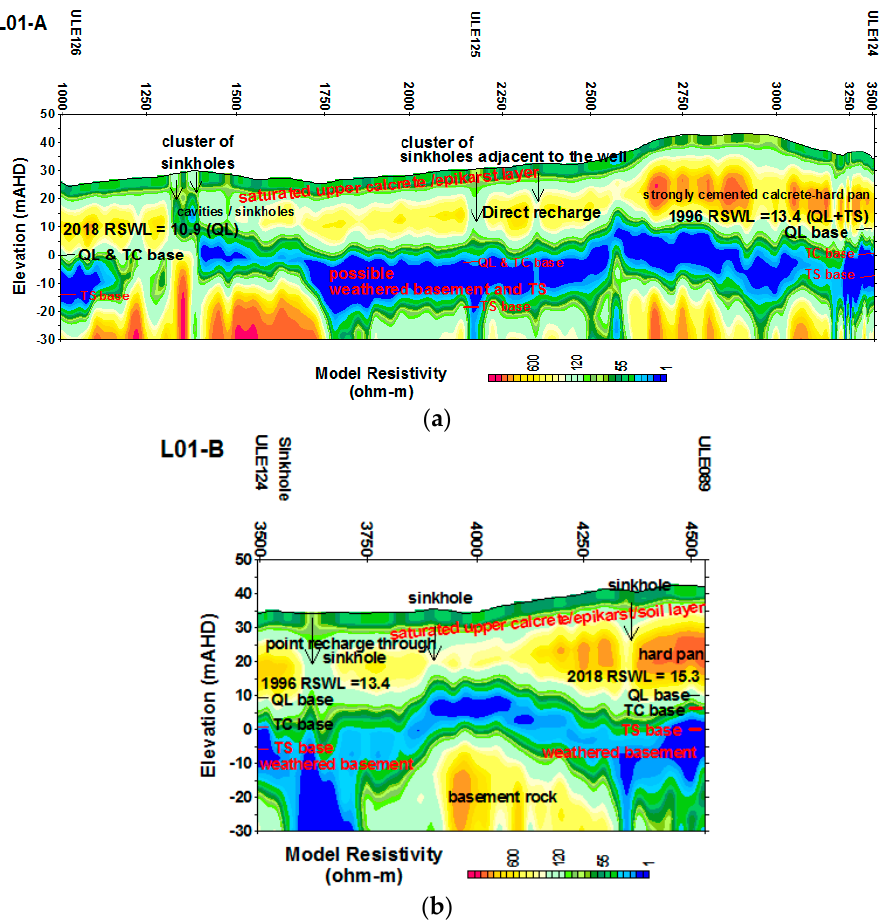
Figure 6. TEM sections for LO1 ( a ) LO1-A (from ULE126 to ULE124) ( b ) LO1-B (from ULE124 to ULE089). As a result of QL and TS aquifers depth-coincident in the TC absent area, higher salinity water from TS enters to QL aquifer resulting in pronounced salinity stratification [25]. Evidence of this is found in the QL aquifer monitoring well, ULE197, down-gradient to TC absent area (Figure 4a) where salinity of the QL base is the same as TS aquifer monitoring well, ULE109, located at the same site. In contrast, the southern half of the QL aquifer has no link to the Big Swamp area or to the Uley East, through either QL or TS aquifers due to high basement at the Uley South Boundary (Figure 4a). Therefore, QL water in the southern part of the Uley South is primarily derived from direct rainfall recharge within the Uley South. The ULE139 is a QL aquifer monitoring well located in the southern part, having low EC water compared to ULE197, and shows no salinity stratification (Figure 7) [25].